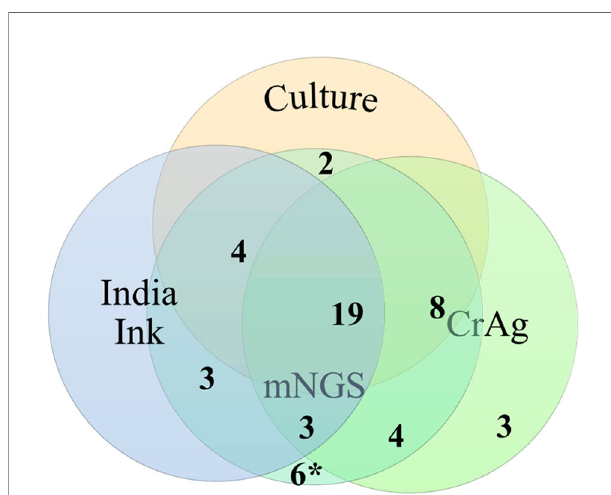
FIGURE 2 | Venn diagram of results of traditional cryptococcal tests and metagenomic next-generation sequencing (mNGS) in 46 patients with cryptococcal central nervous system (CNS) infection. The number of cases detected using culture, India ink, cryptococcal capsular polysaccharide antigen (CrAg), and mNGS was 43, 46, 38, and 46, respectively.*, six mNGS false-positive cases validated by traditional cryptococcal diagnostic tests.